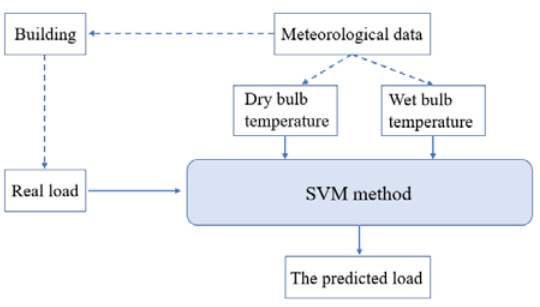
Figure 5. The flow chart of the support vector machines (SVM) method.